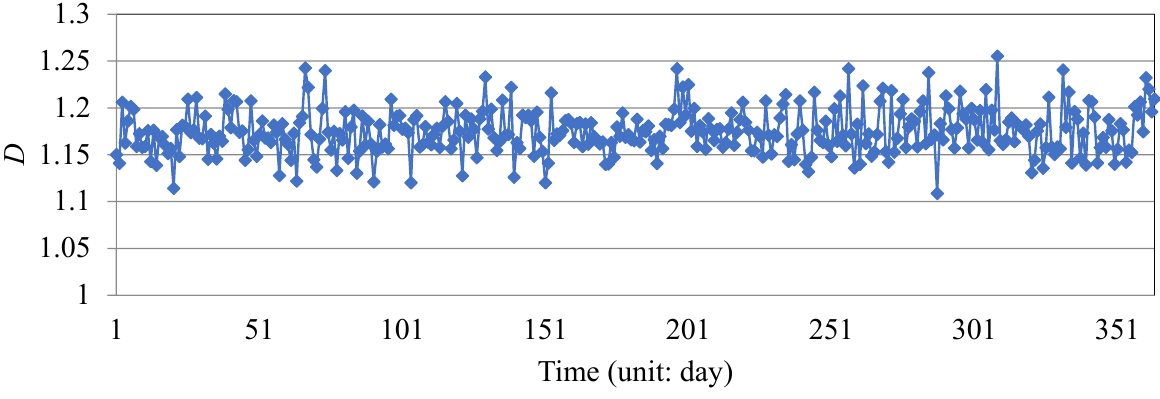
Figure 4. Fractal dimension of daily wind speed.